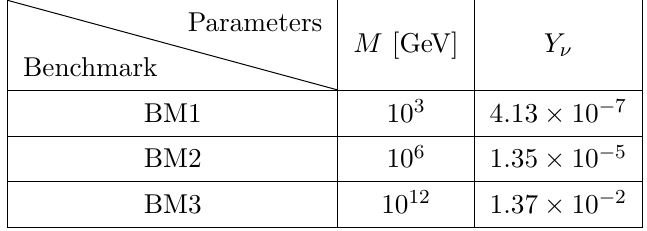
Table 10 . Three representative benchmark points for the type-I and -III seesaw models for illus- trating radiative generated electroweak spontaneous symmetry